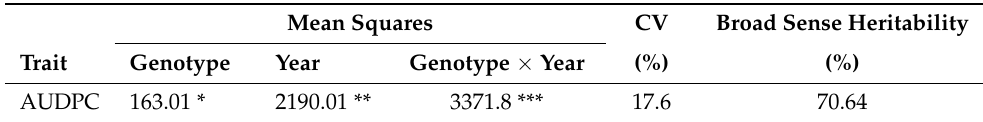
Table 1. Mean squares and heritability estimate for yam anthracnose disease severity in the mapping population. Mean Squares CV Broad Sense Heritability Trait Genotype Year Genotype × Year (%) (%) AUDPC 163.01